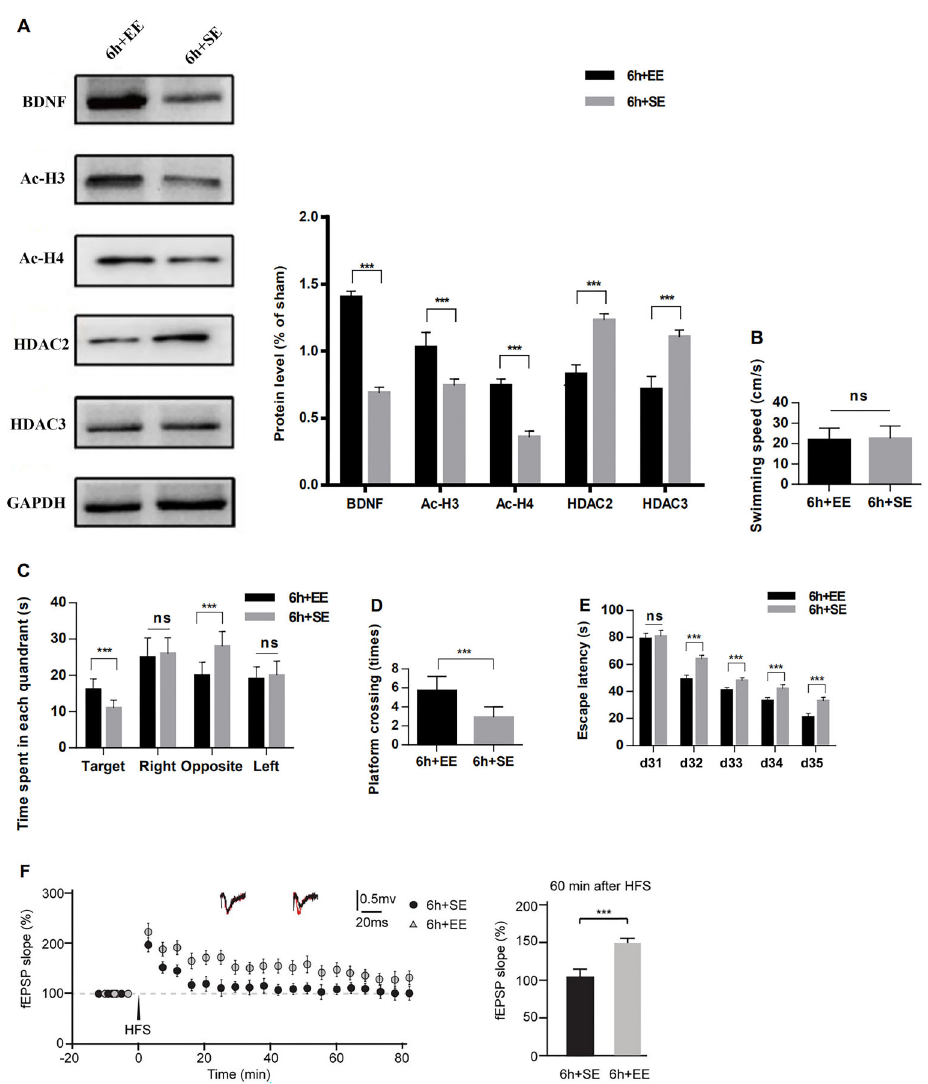
Figure 4. Enriched environment (EE) ameliorated impairment in long-term potentiation (LTP), spatial learning, and memory of postnatal- day-35 offspring rats induced by sevo fl urane exposure compared to standard environment (SE). A , Compared to the 6-h group, EE increased BDNF, Ac-H3, and Ac-H4 and reduced HDAC2 and HDAC3. B , There was no signi fi cant difference in swimming speed. C , The time spent in the target quadrant was increased and the time in opposite quadrant was decreased. D , Platform crossing times were increased and E , escape latency was decreased. F , Long-term potentiation measured in fi eld evoked postsynaptic potentials (fEPSP) was enhanced in the 6-h + EE group. ***P o 0.001 (t-test). ns: not signi fi